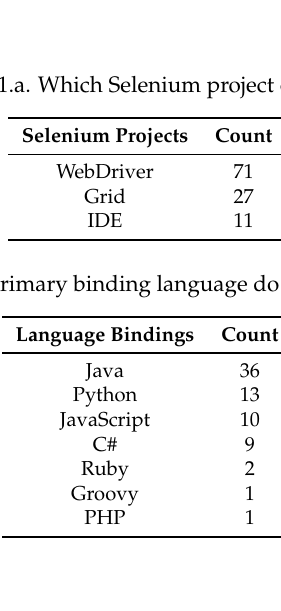
Table A3. 2.a. Which browser do you automate with